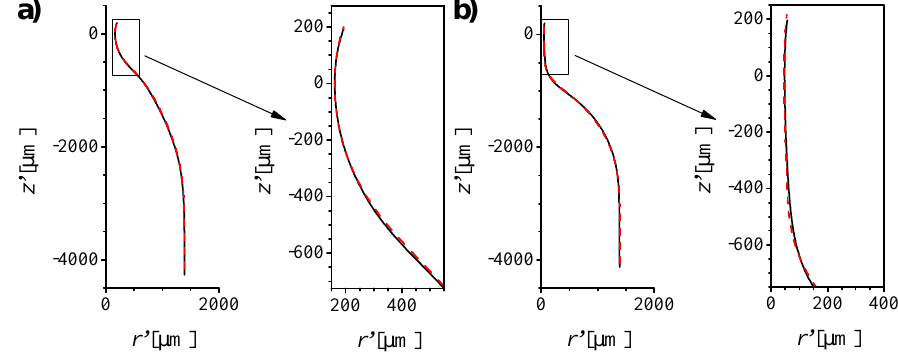
Figure 4. Shape comparison for sets of two nozzles (black and red lines) of the same diameter produced with the same heating conditions from capillaries type 1: ( a ) r = 3.5 mm, t = 75 s, D ≈ 300 µ m; ( b ) r = 3.5 mm, t = 180 s, D ≈ 100 µ